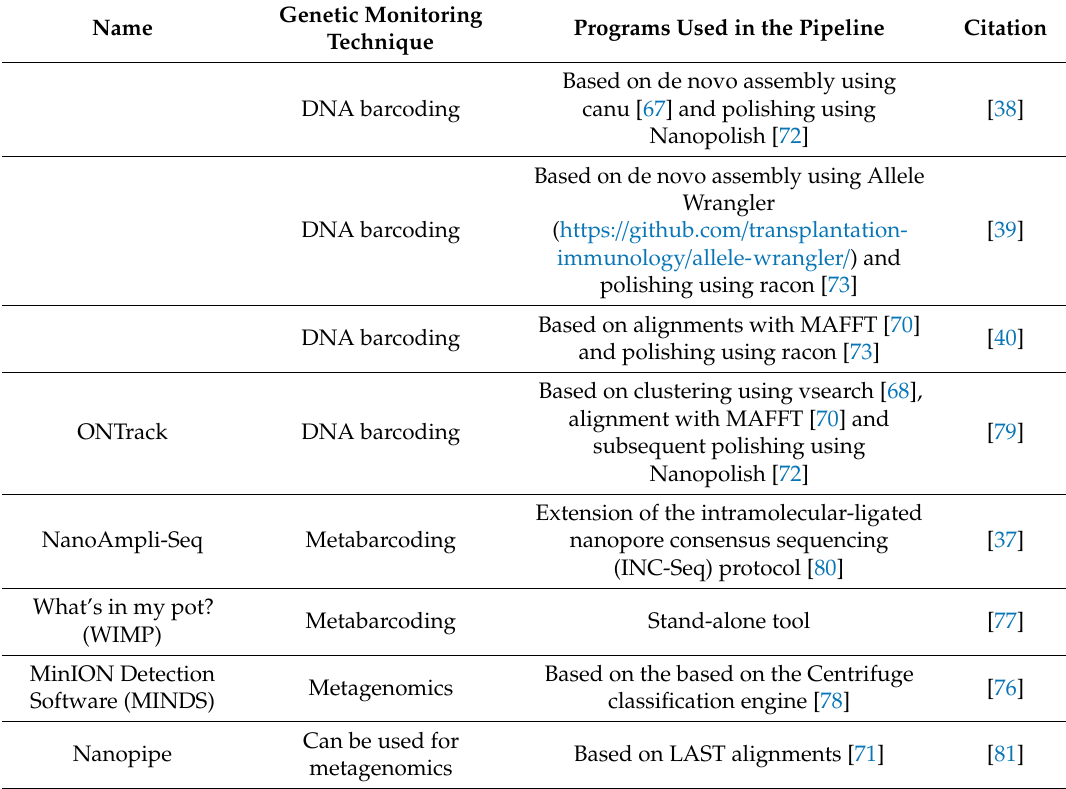
Table 2. Available pipelines for bioinformatic processing of genetic monitoring data generated with the MinION